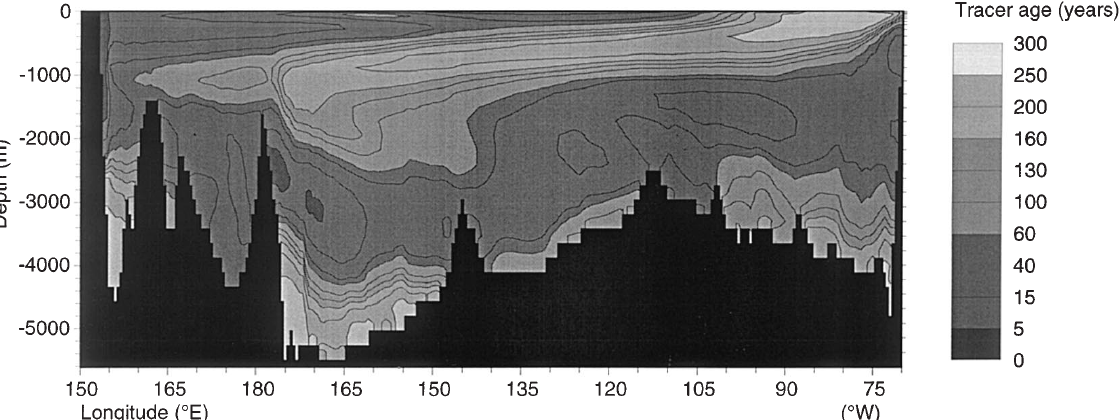
Fig. 3. A zonal section at 27 (cid:14) S from Australia (150 (cid:14) E) to South America (70 (cid:14) W), illustrating the age of tracer introduced at the Pacific Ocean boundary (24 (cid:14) S)